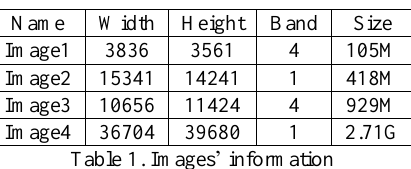
Figure 4. Images used for